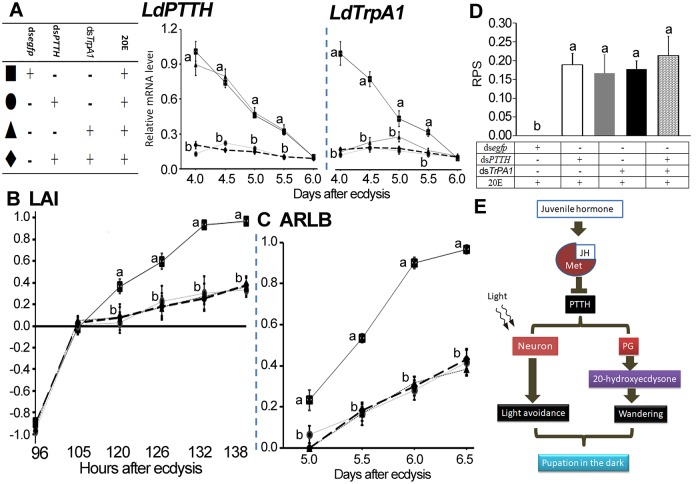
PTTH signal affects photo transduction to promote light sensing.Dsegfp+20E, dsPTTH+20E, dsTrpA1+20E and dsPTTH+dsTrpA1+20E were dietarily introduced to the larvae. Significant differences in transcript abundance of LdPTTH and LdTrpA1 (A), light avoidance index (LAI) (B), accumulated rate of larvae that had buried in soil (ARLB) (C) at each testing time point, and rates of pupae on the soil (RPS) (D) through a two-week experiment period to those in control (dsegfp+20E-fed) were indicated by different letters (P<0.05). (E) A model depicting the hormonal cascade regulating the light avoidance of the wandering larvae (see text for details).